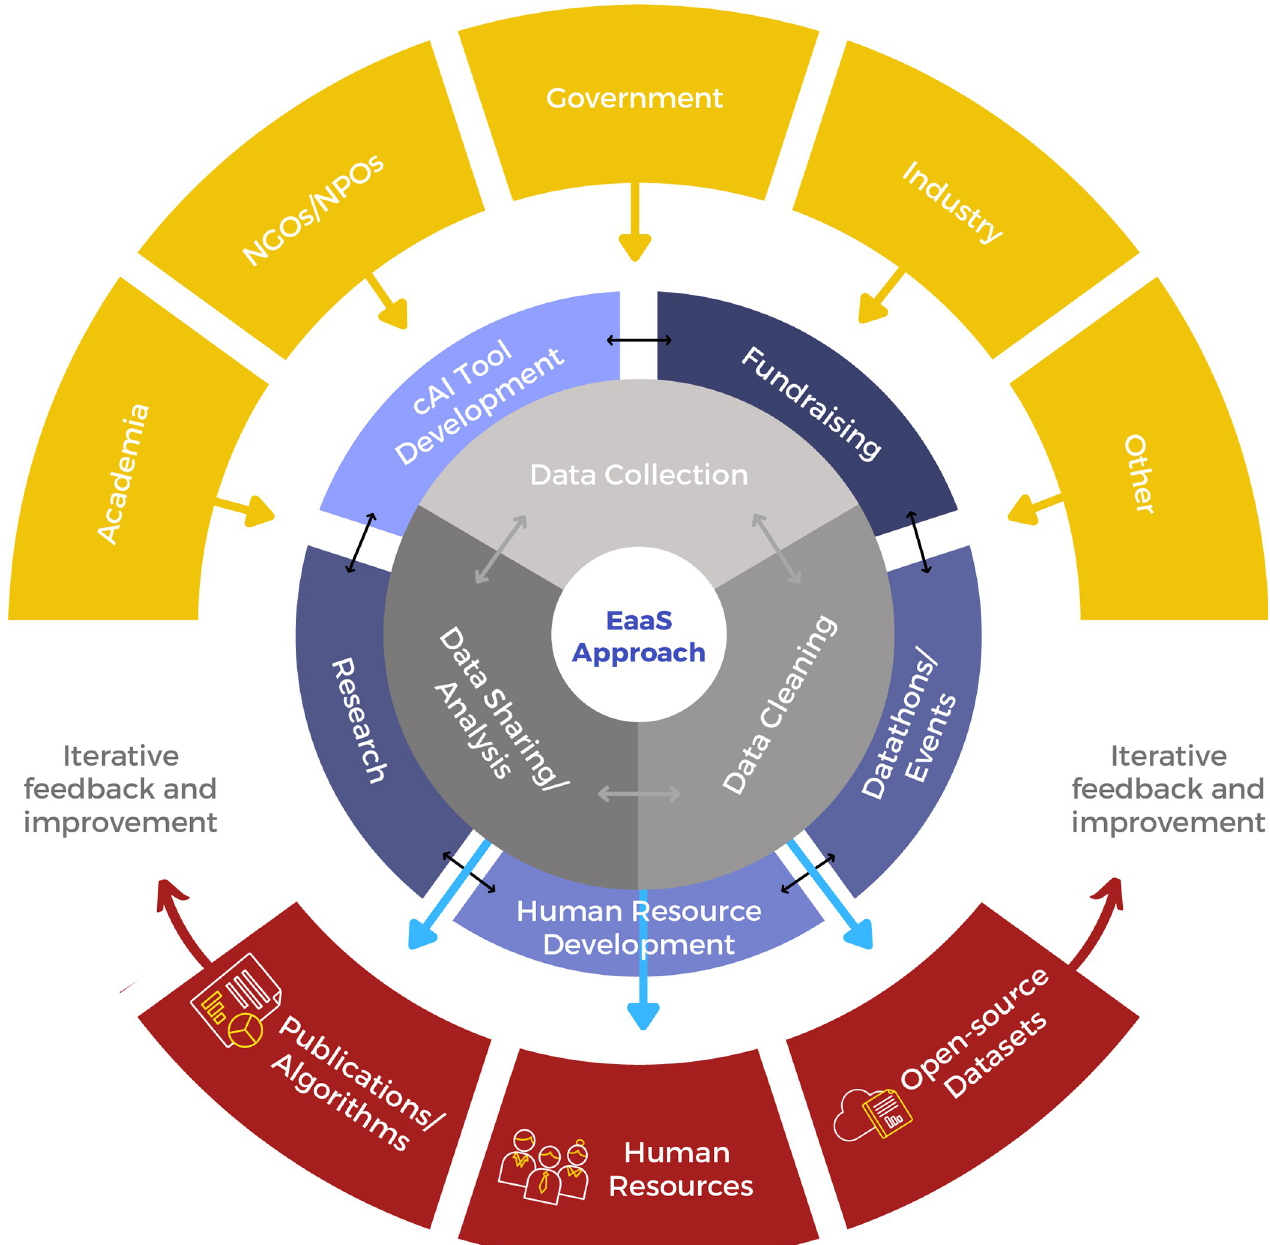
Fig 2. Stakeholders and Operations of the EaaS approach. High-level depiction of the stakeholders included in the EaaS approach, its operational components, as well as its iterative nature.